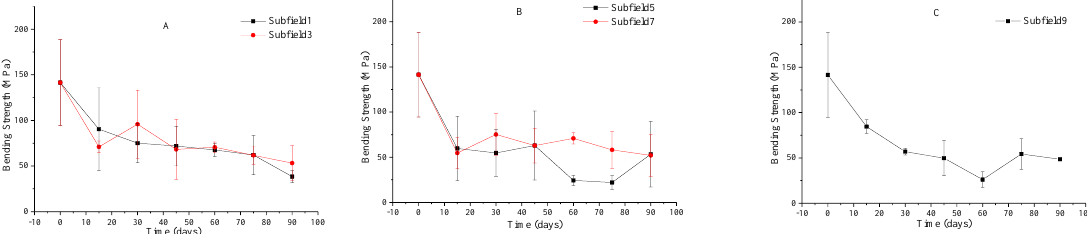
Figure 9. Changes in the bending strength over time with different tillages. Note: ( A )—Plowing; ( B )—Dry rotary; ( C )—Wet Rotary.